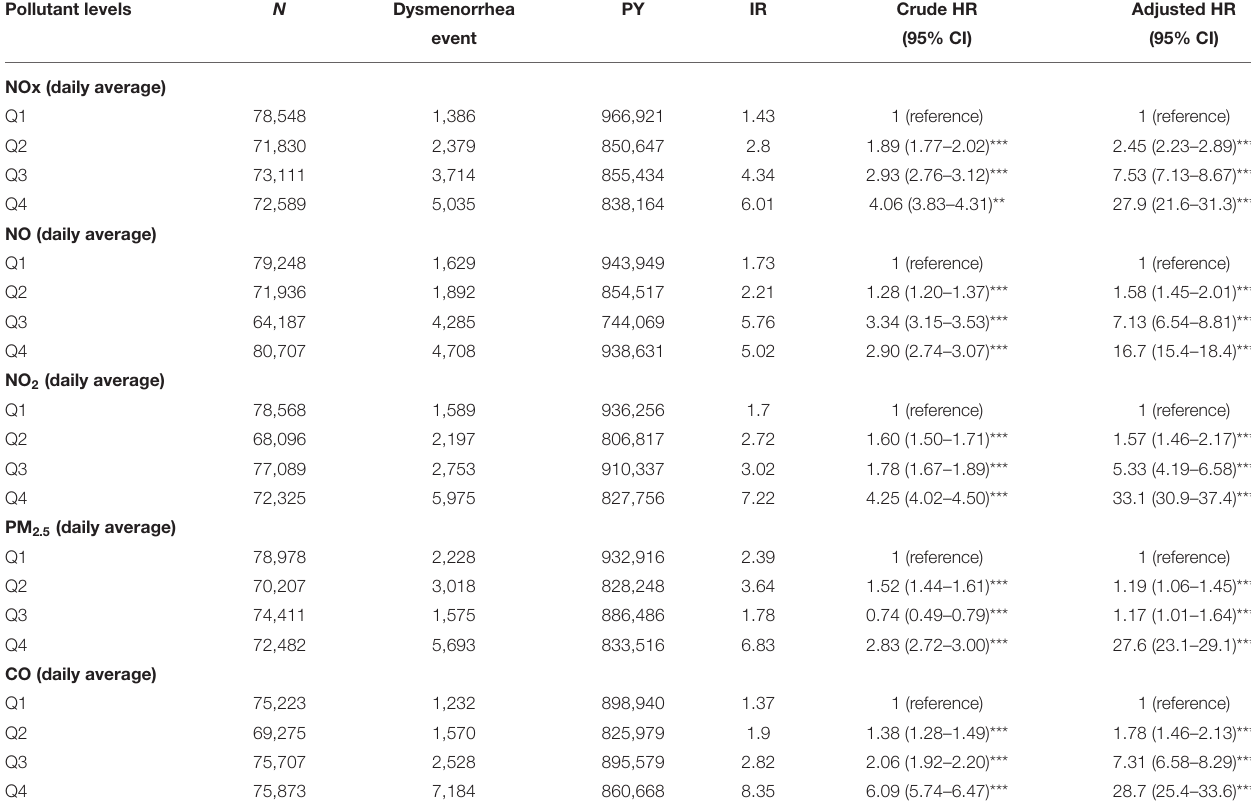
TABLE 2 | Difference in dysmenorrhea incidences and associated HRs in participant exposed to various daily average concentration of air pollutants. Pollutant